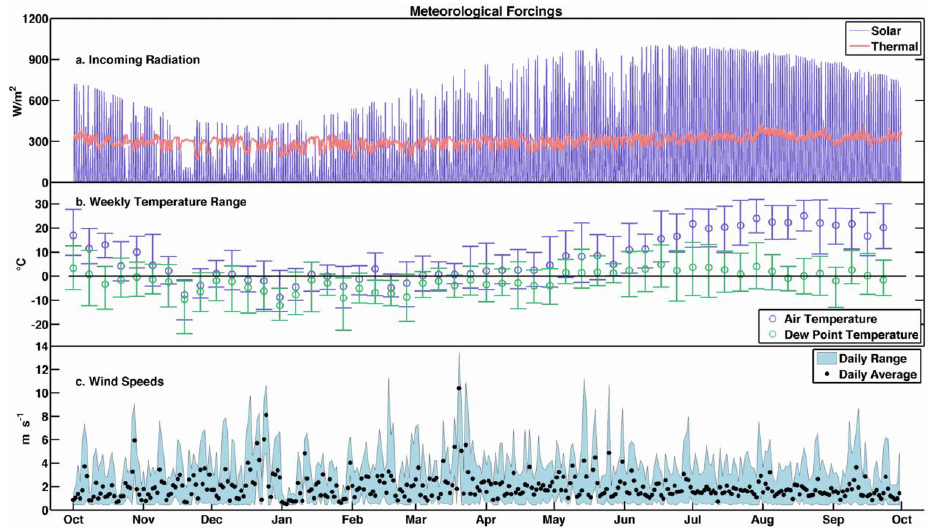
Figure 3. Weather data measured at the Treeline experimental catchment for WY2011. (a) presents incoming measured and gap-filled solar Figure 3. Weather Data measured at the Treeline experimental catchment for WY2011. Figure 2 and thermal radiation. (b) presents weekly average, minimum, and maximum air and dew point temperatures. (c) presents measured daily average, minimum, and maximum wind 3a presents incoming measured and gapfilled solar and thermal radiation. Figure 3b 3